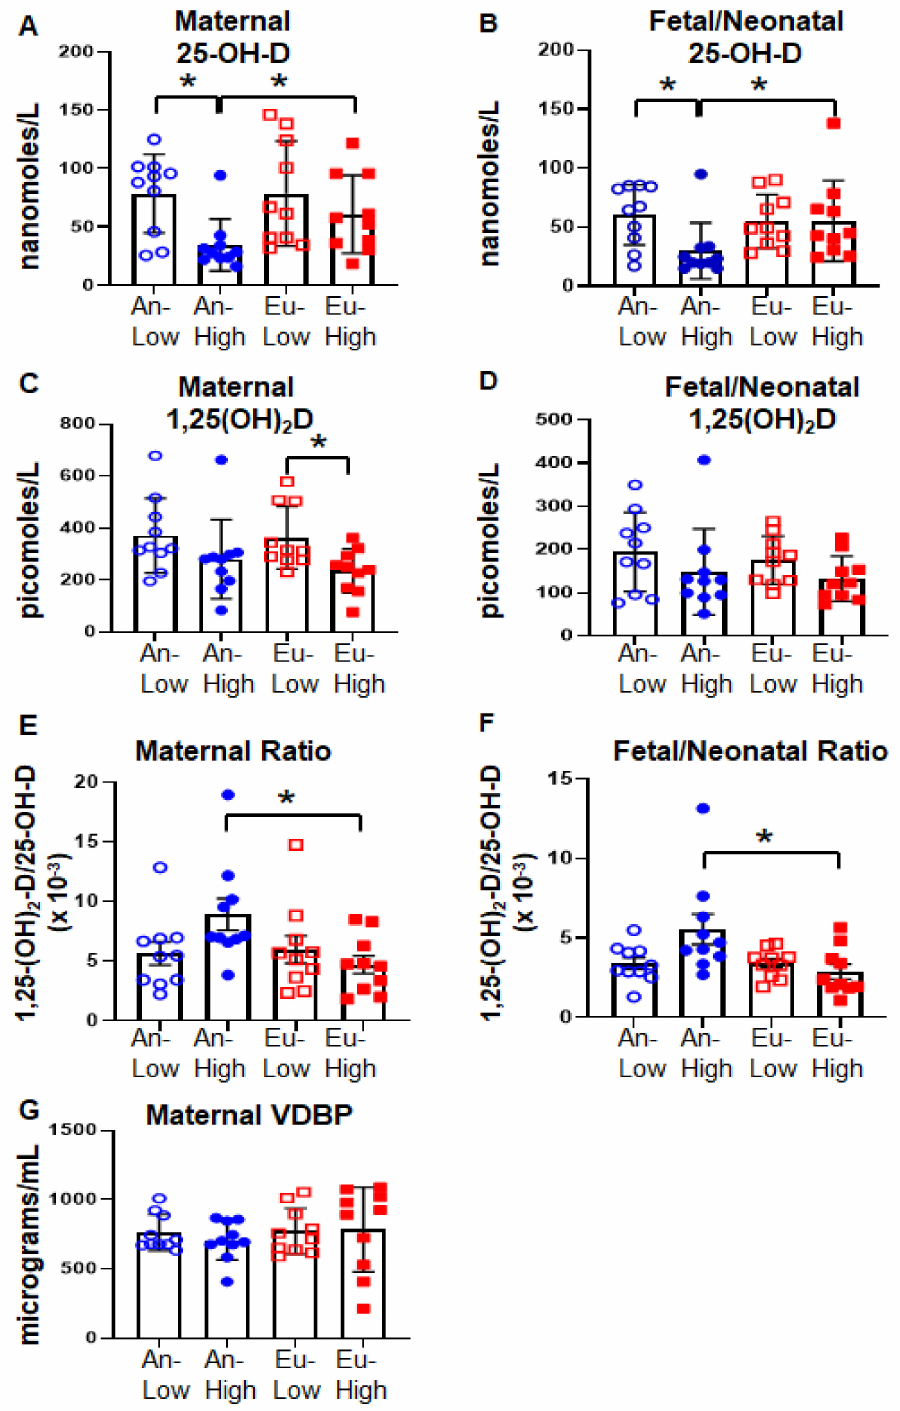
Figure 1. Vitamin D status in Bolivian pregnancies. Vitamin D metabolite circulating levels were determined in maternal and umbilical cord blood of 40 mother/fetus dyads divided into four groups according to altitude residence and genetic ancestry via ELISA as explained under methods. ( A ) maternal 25-OH-D, ( B ) umbilical cord 25-OH-D, ( C ) maternal 1 α ,25-(OH) 2 -D, ( D ) umbilical